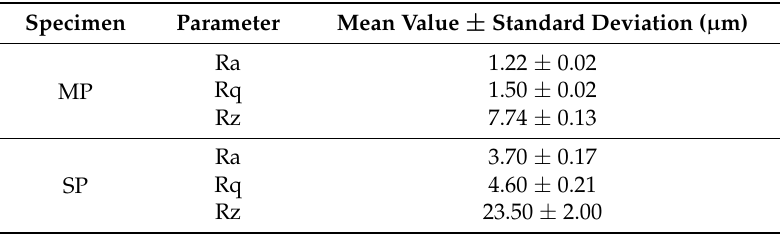
Table 2. Surface roughness parameters for Mechanically Polished (MP) and Shot Penned (SP)